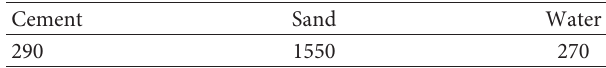
Figure 2: The three-view drawing of the brick wall (unit: mm). (a) Front view. (b) Right view. (c) Back view. (d) Left view. Table 1: Proportions of mortar mixtures (kg/m 3